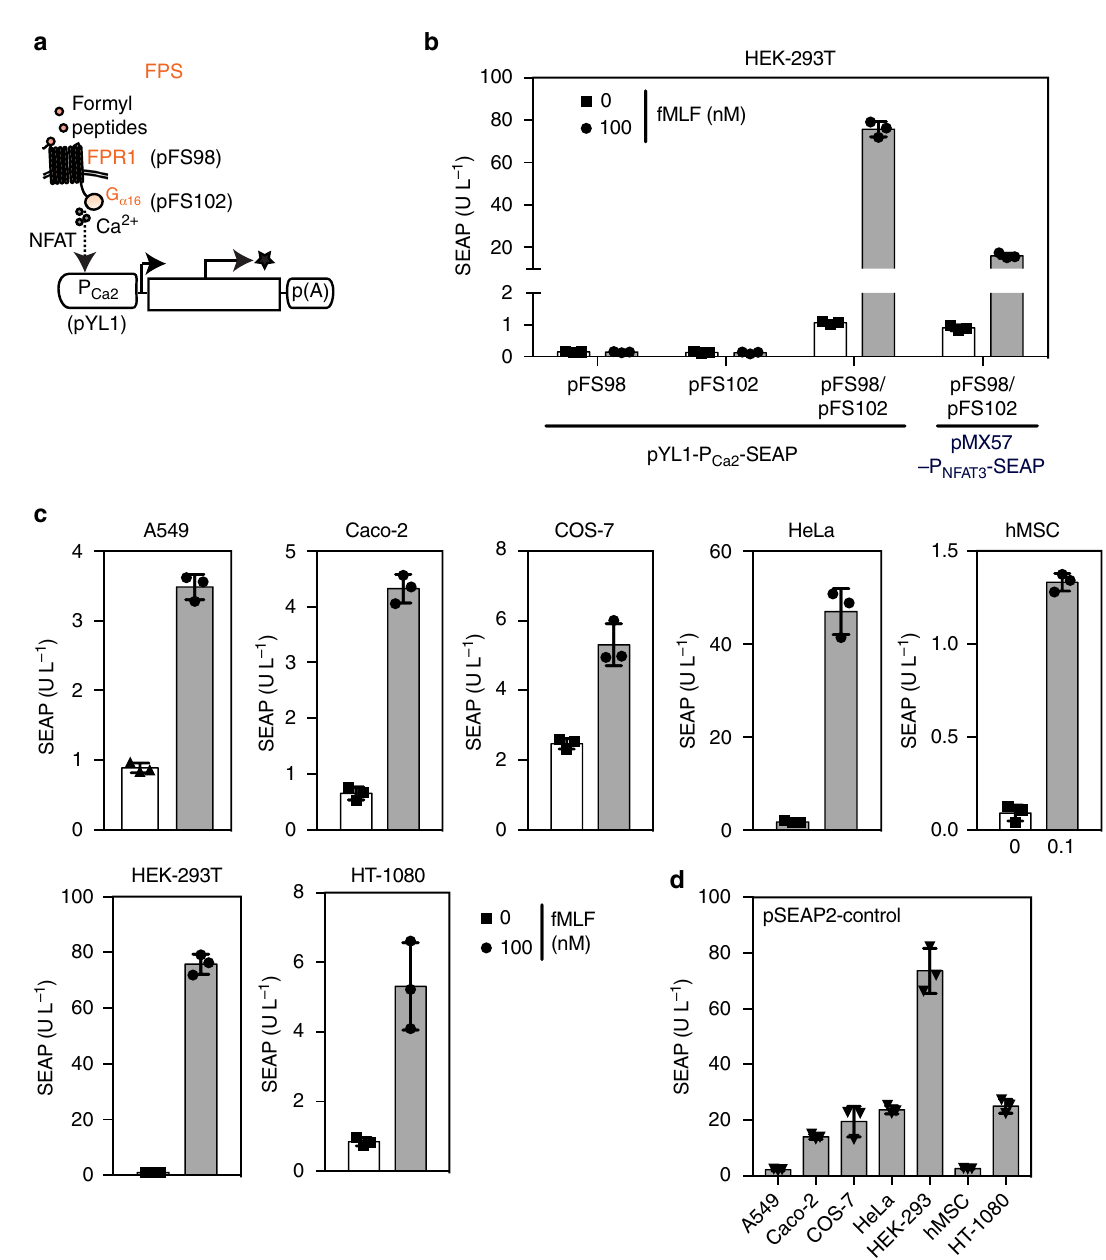
Fig. 2 A formyl peptide-sensitive transcription control module. a Schematic representation of the formyl peptide sensor (FPS) connected to intracellular (Citrine; P Ca2 -Citrine-pA, pFS220) or secreted (SEAP; P Ca2 -SEAP-pA, pYL1) reporter proteins. b Validation of FPS components. HEK-293 cells transgenic for the FPS were cotransfected with the G protein-coupled receptor FPR1 (P SV40 -FPR1-pA, pFS98), the G Protein G α 16 (P SV40 -G α 16 -pA, pFS102) and a calcium-responsive reporter, (P Ca2 -SEAP-pA, pYL1) or (P NFAT3 -SEAP-pA, pMX57), to produce SEAP in response to fMLF, in contrast to control cells lacking either the calcium pathway-rerouting G α 16 or the FPR1 sensory module. c Formyl peptide-induced SEAP expression in different cell lines. HeLa, COS-7 and HEK-293 were cotransfected with the FPR1-encoding expression vector (P SV40 -FPR1-pA, pFS98), the G α 16 -encoding expression vector (P SV40 -G α 16 -pA, pFS102) and the P Ca2 - driven SEAP reporter plasmid (P Ca2 -SEAP-pA, pYL1), while hMSC-TERT, A549, Caco-2 and HT-1080 were engineered with the FPR1-encoding expression vector featuring the human elongation factor 1 alpha (P EFI α ) promoter (P EFI α -FPR1-pA, pFS115), the P hCMV -driven G α 16 expression vector (P hCMV -G α 16 -pA , pcDNA3.1-G α 16 ), together with the reporter plasmid (pYL1). Cells were grown in the presence or absence of N-formyl peptide, and SEAP levels were pro fi led in the culture supernatant after 24h. d Transfection ef fi ciency of engineered cell lines. Cells were transfected with a constitutive SEAP expression vector (pSEAP2- control) and SEAP levels were quanti fi ed after 24h. Data are means±SD and symbols indicate means of individual experiments ( n =